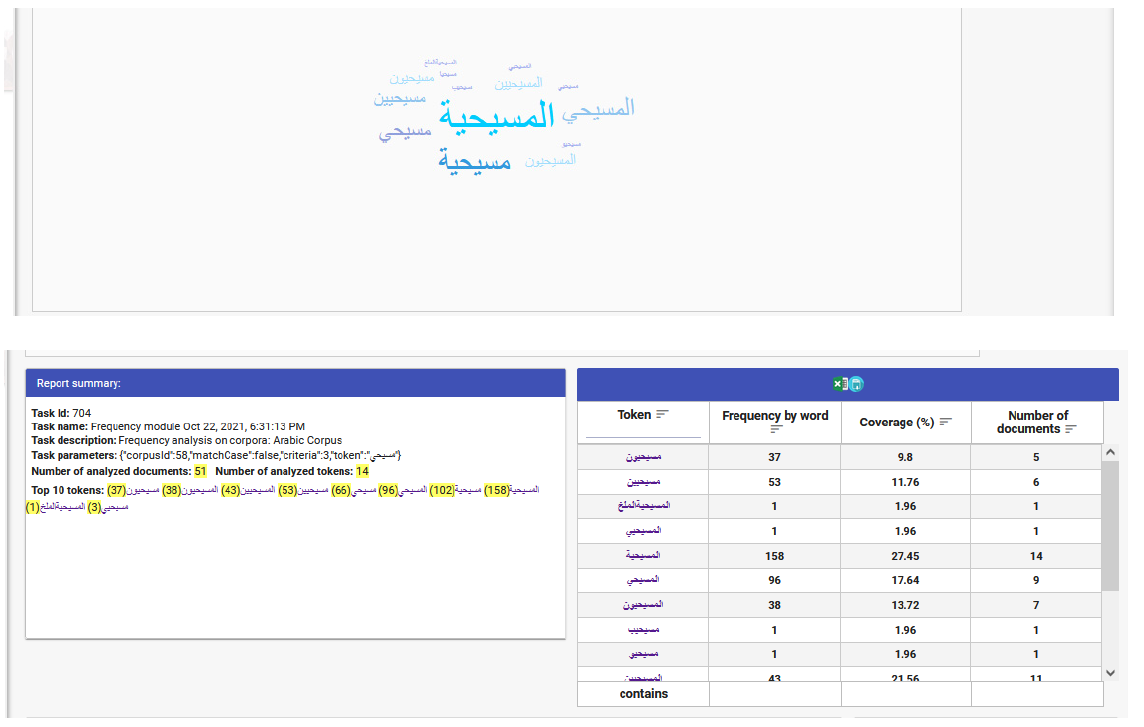
Figure 6. Frequency analysis report for the word “Christian” or “mas ī ḥ ī ” “ﻲﺤﻴﺴﻣ” to find out, for example, how many times it is referred to as the “other” with his/her religion.